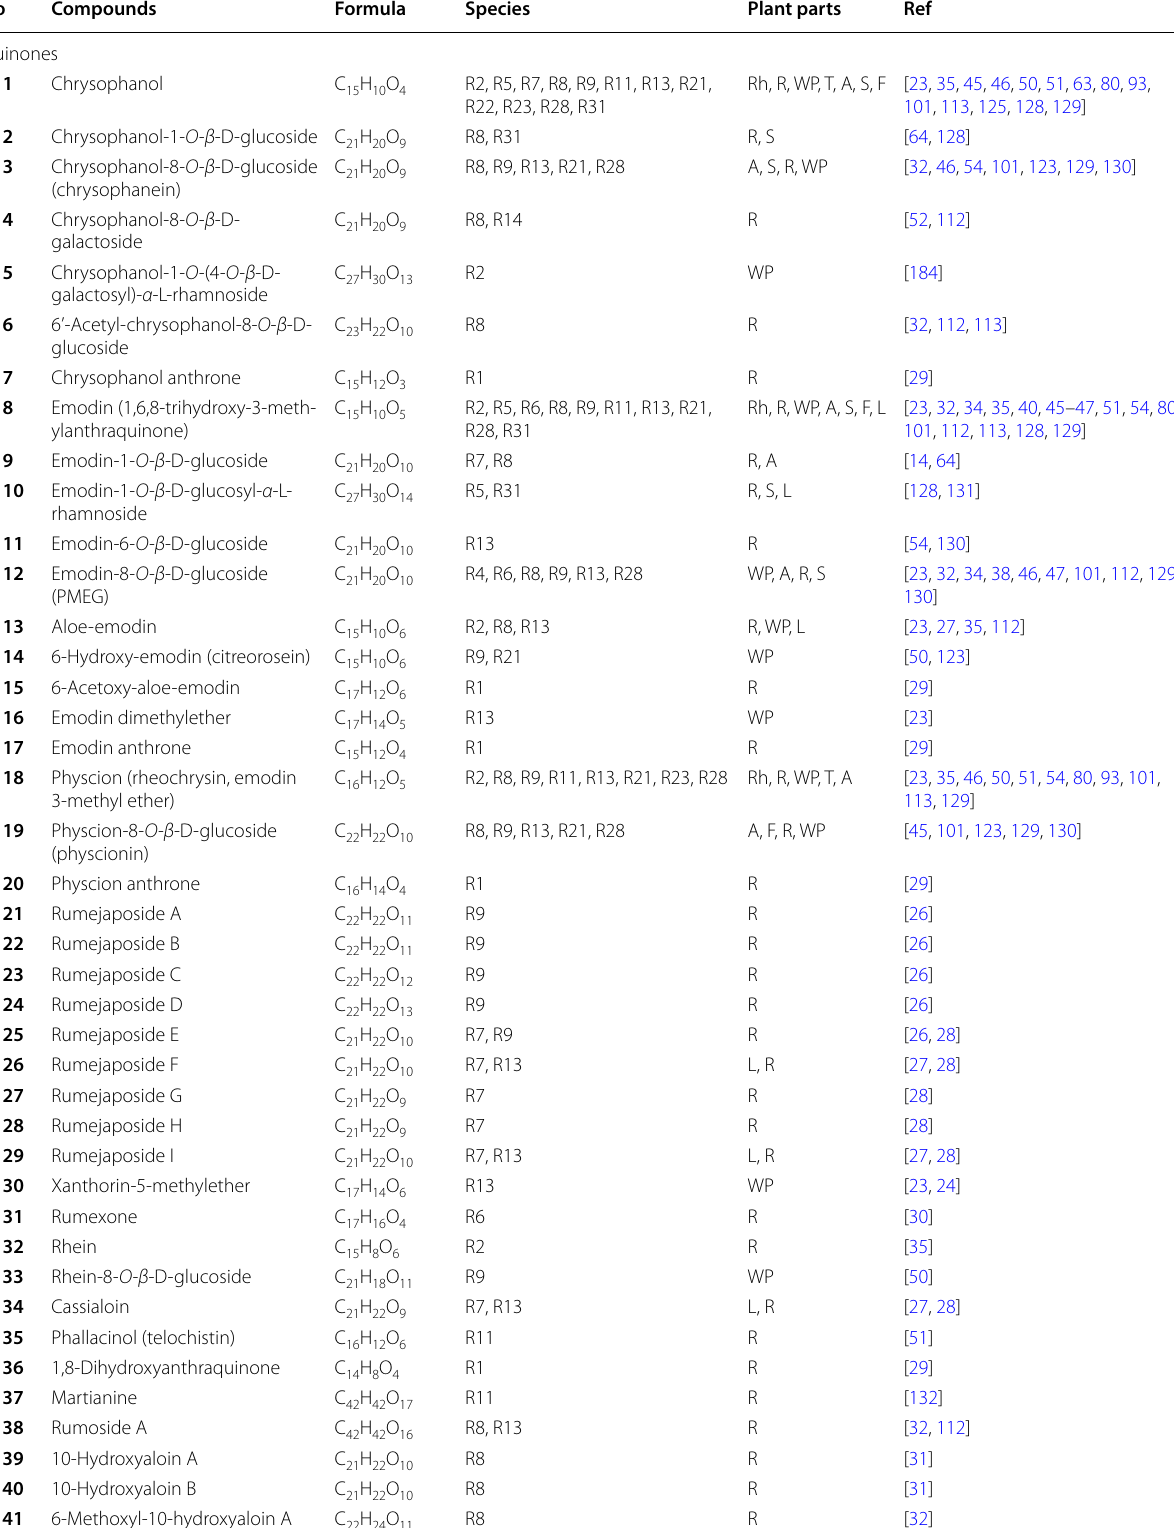
Table 2 The summary of compounds in